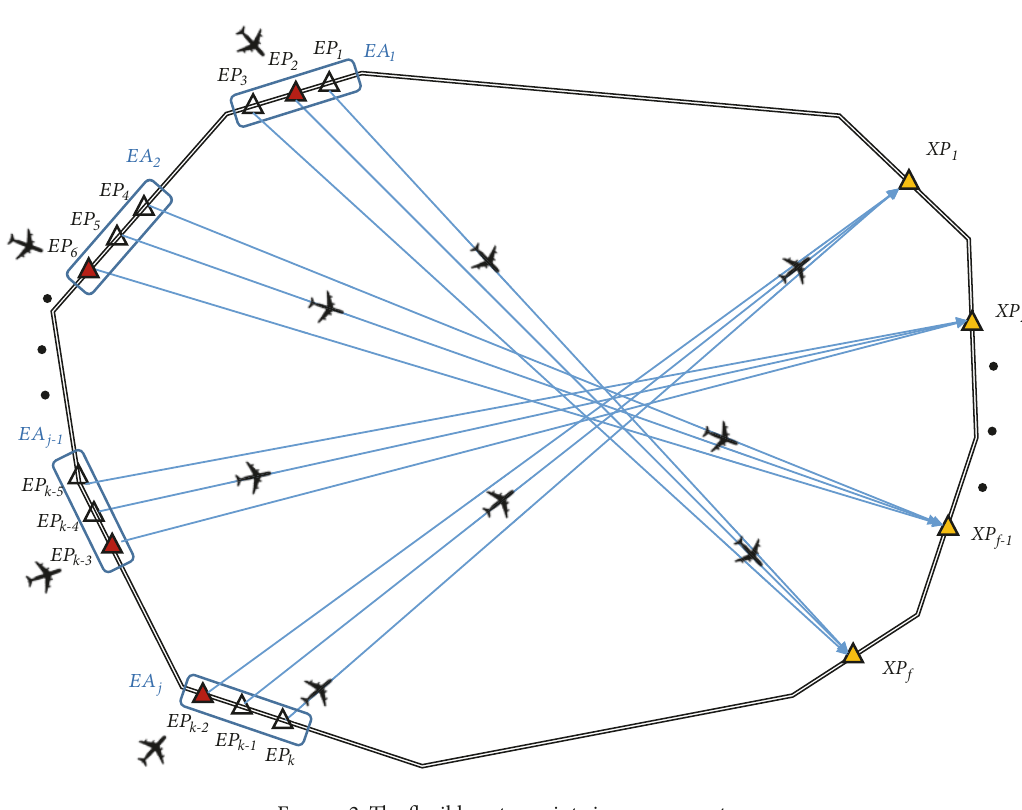
Figure 2: The flexible entry point airspace geometry.